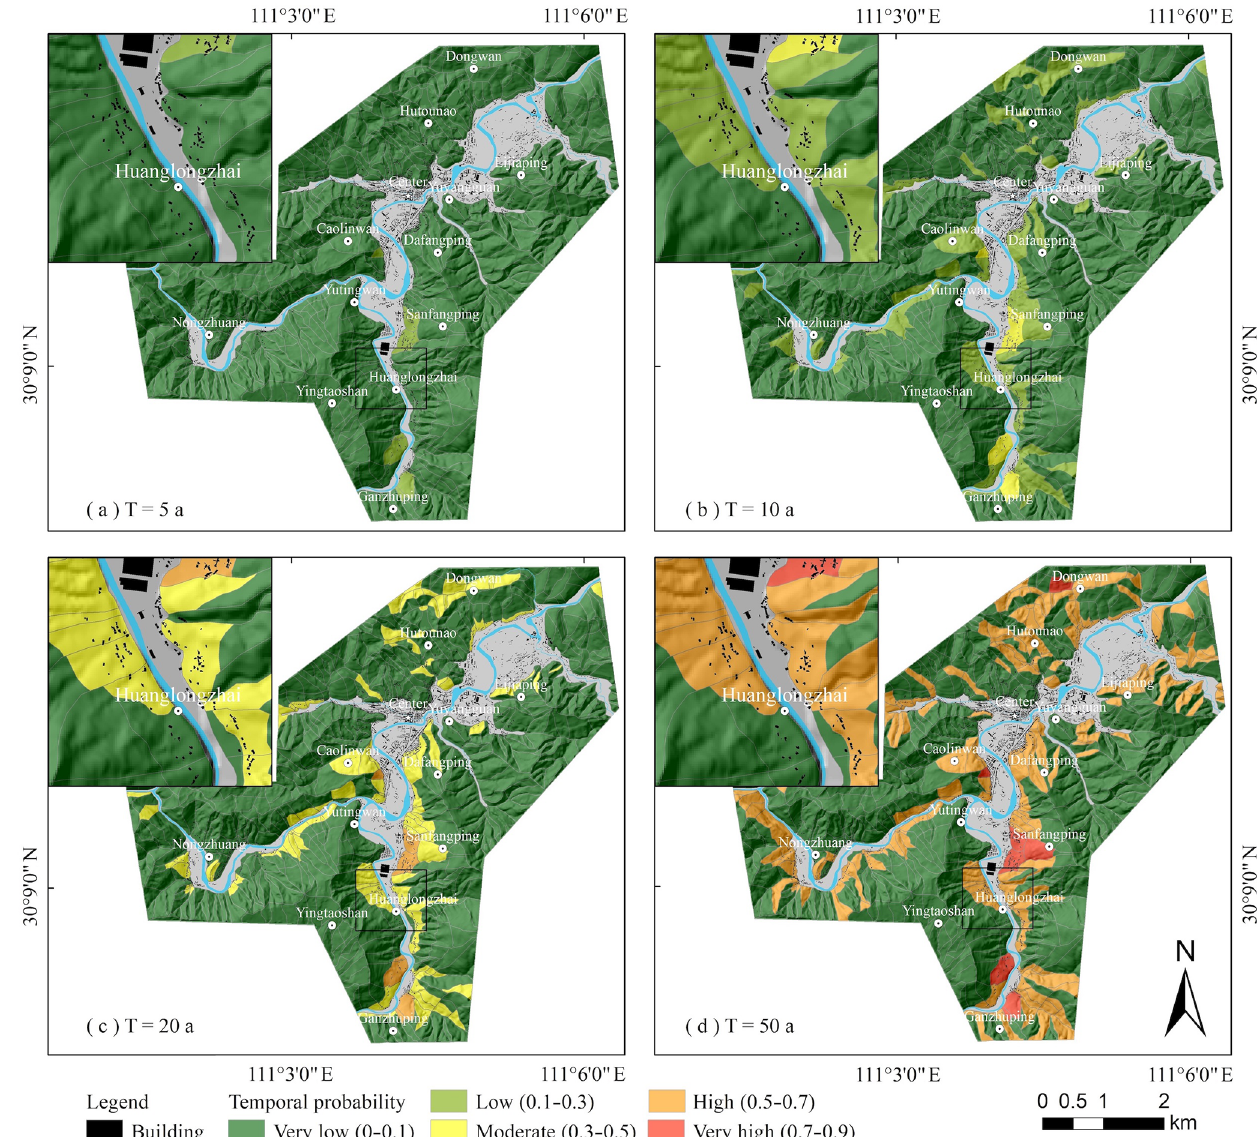
Figure 9. Landslide temporal probability maps based on the Poisson model, showing the exceedance probability of landslide occurrence in each slope unit for four return periods (5, 10, 20, 50